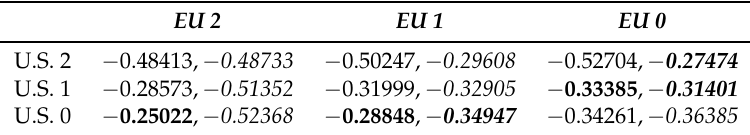
Table 3. Payoff matrix for both players for each combination of strategies for C r =